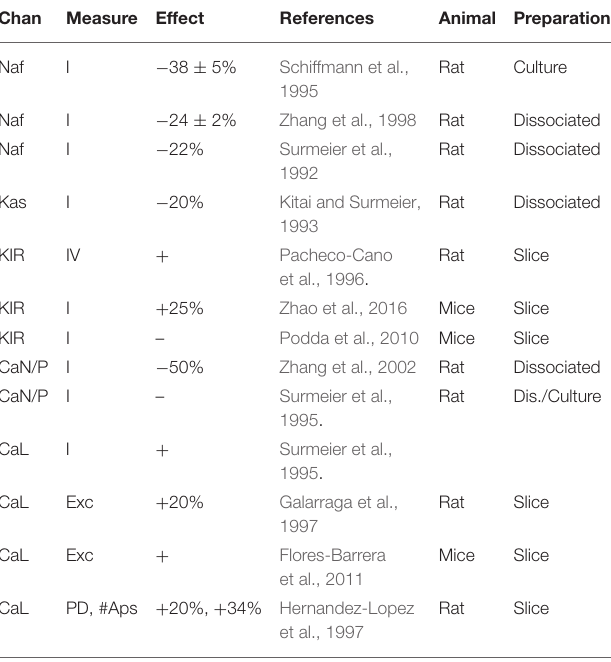
TABLE 3 | Summary of the literature study on single channel effect of D1R activation in